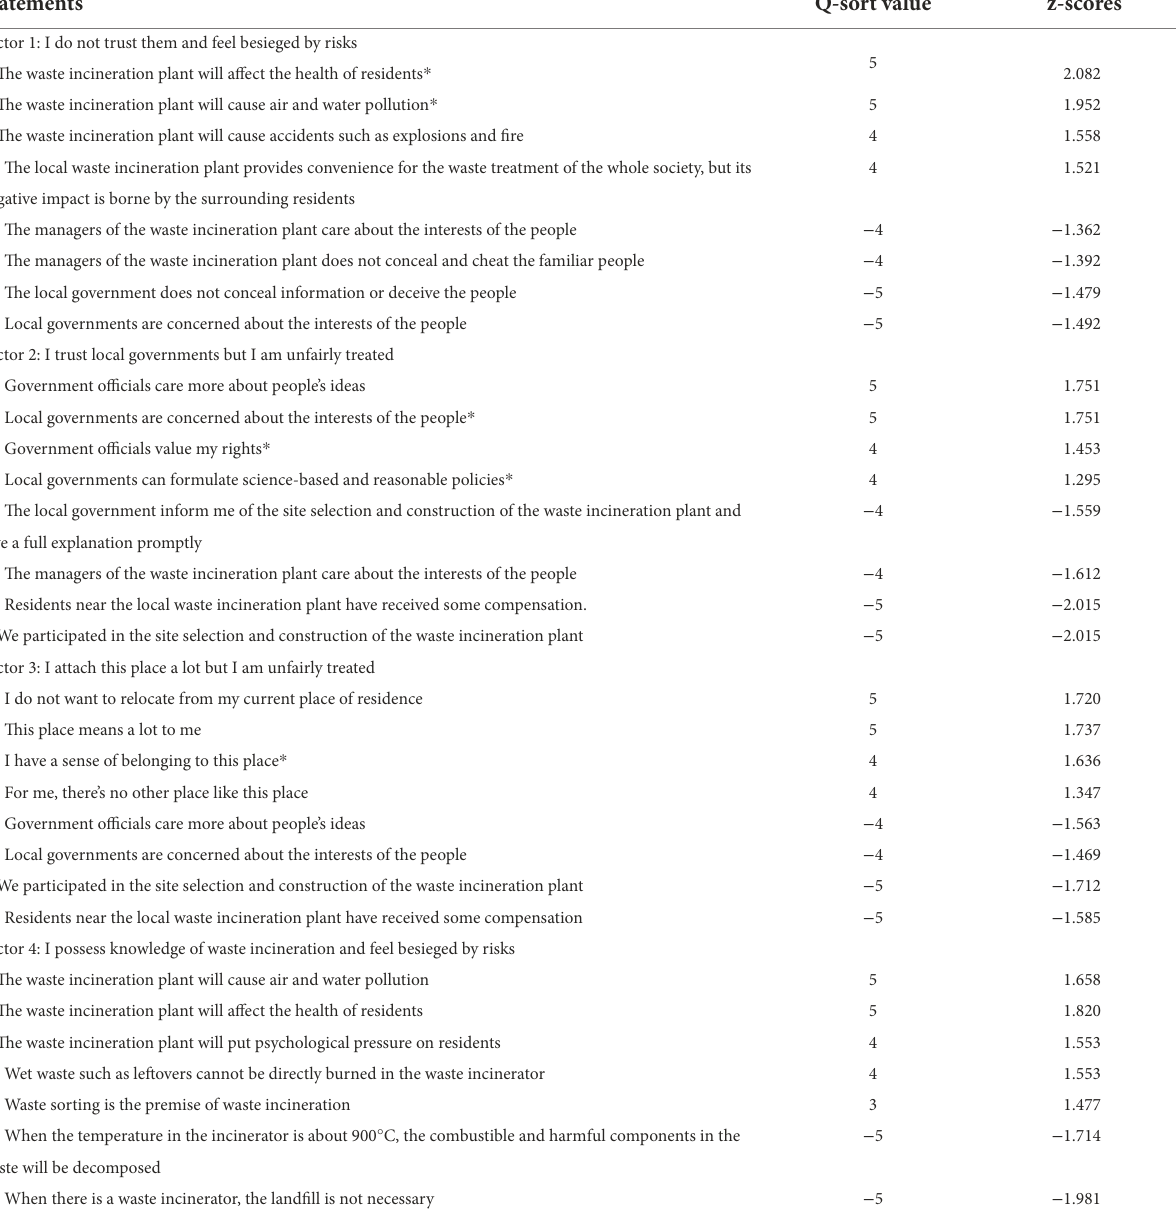
TABLE 4 Overview of the four perspectives and their extreme item statements with normalized Q-sort values and